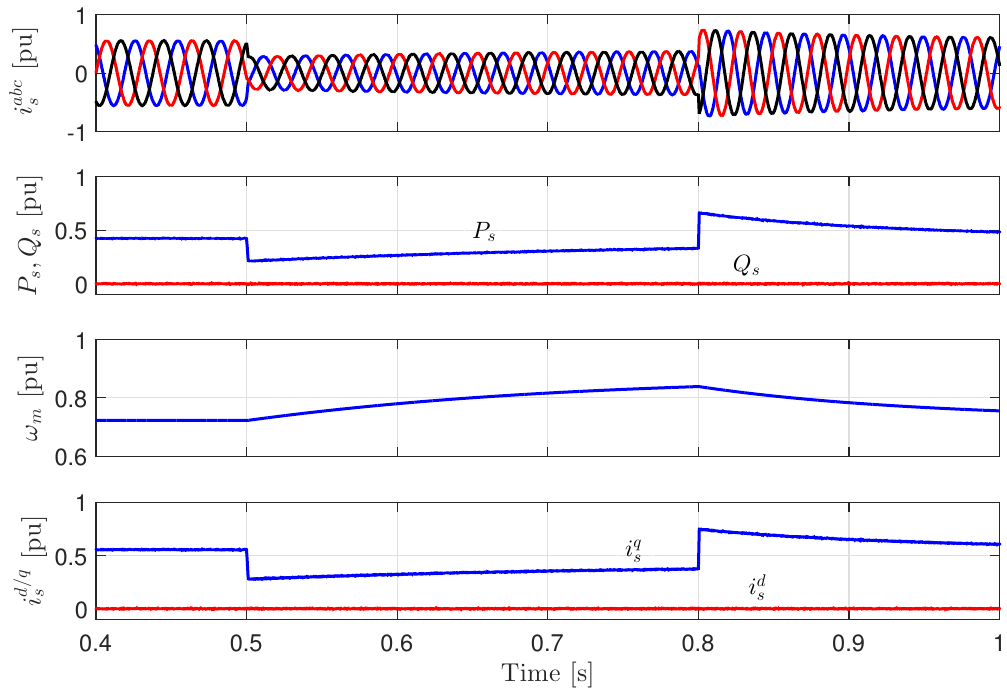
Figure 9. Performance of the MSC and PMSG during a single phase to ground fault with the proposed FRT strategy (from top ): PMSG output currents i abc s = ( i a s , i b s , i c s ) (cid:62) , PMSG active and reactive power ( P s , Q s ), mechanical speed of the PMSG rotor ω m , and d - and q -axis currents of PMSG ( i d s , i q s